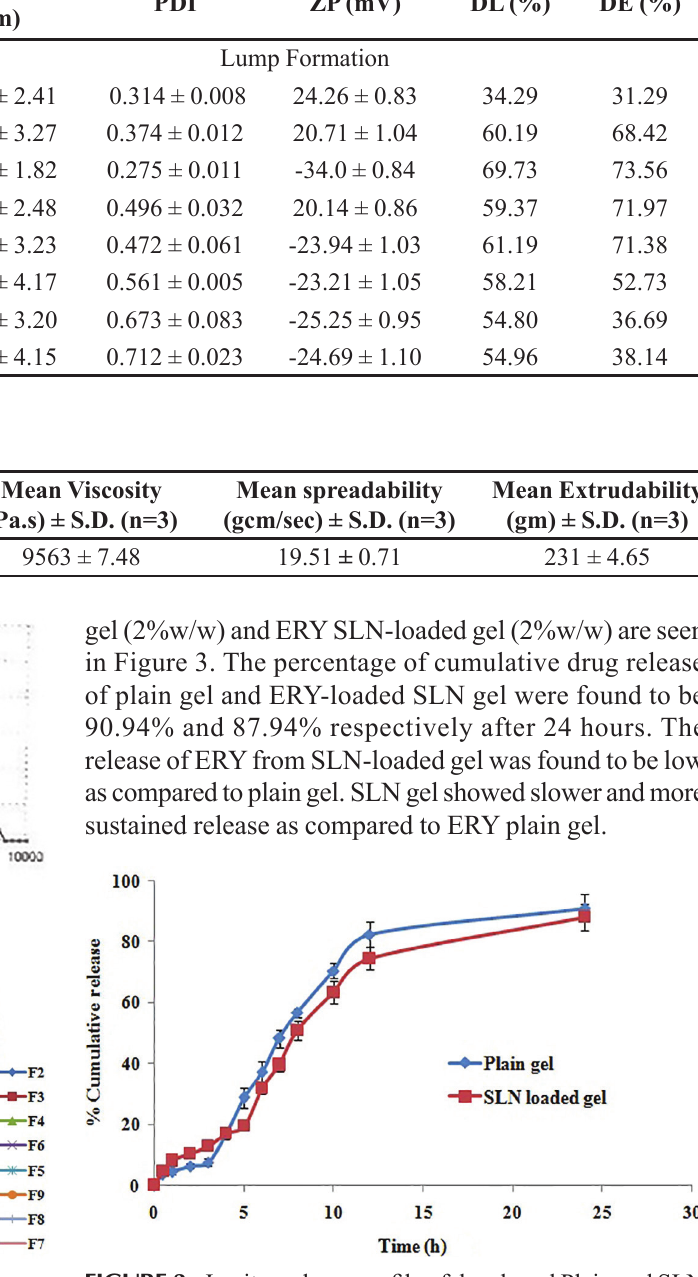
TABLE VIII - Codes for four variables at three different levels Codes